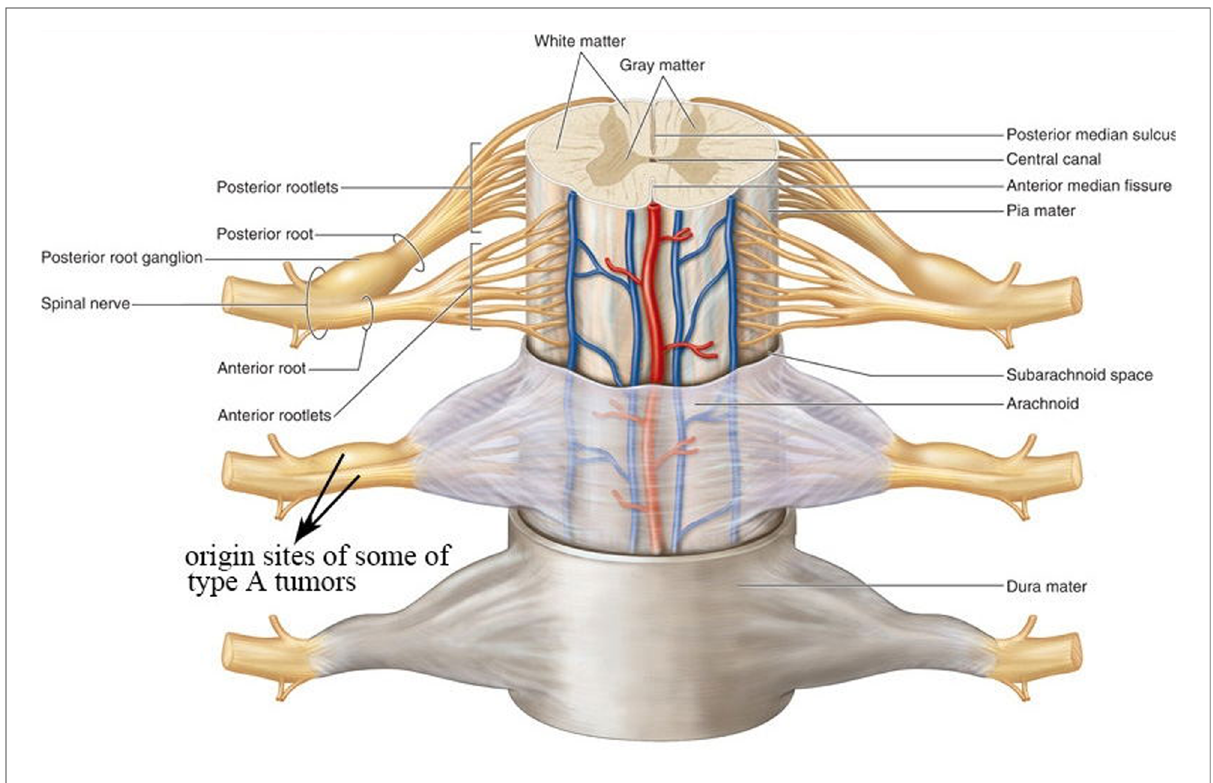
FIGURE 7 Origin sites of some of type A